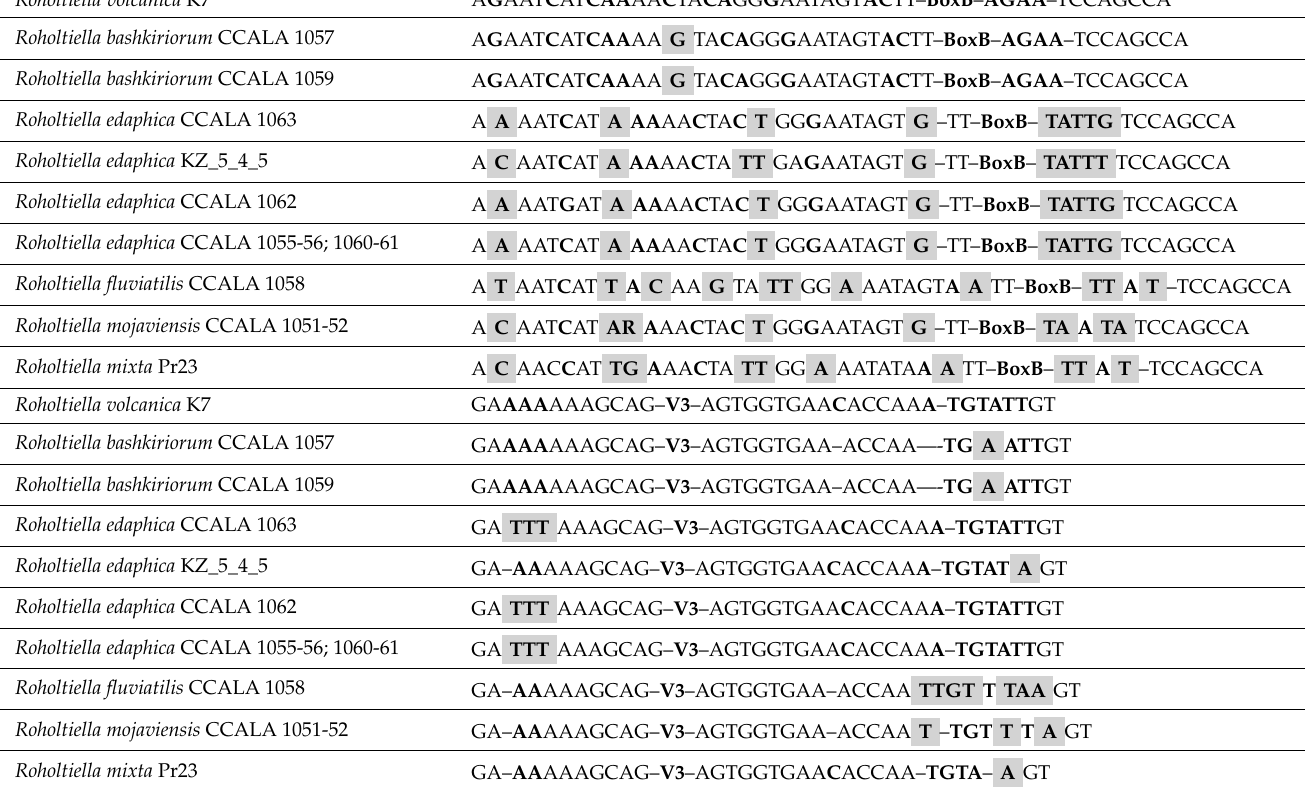
Table 1. Sequences of 16S–23S ITS flanking region of the BoxB and V3 helices for Roholtiella species. Variable bases are in bold and the differences between R. volcanica and all other strains are highlighted in grey for each of those strains. Note that the fewest differences are between R. volcanica and R. bashkiriorum